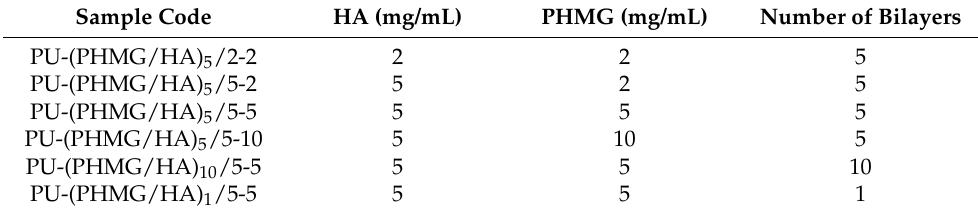
Table 1. The formulations of the PU-(PHMG/HA) n films